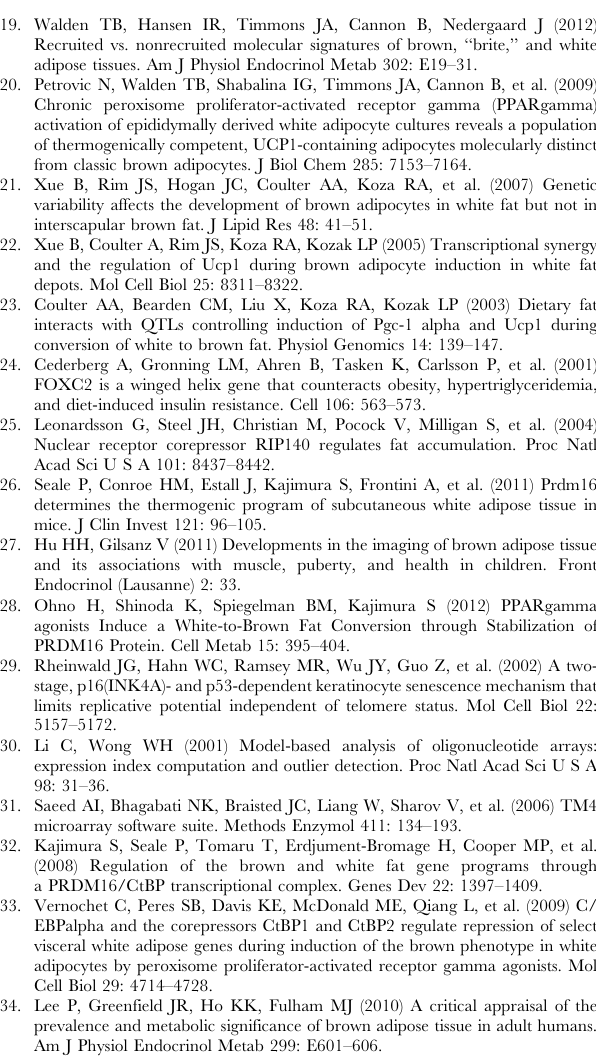
Figure S1 Expression profile after normalizing the each gene mRNA level with that of primary skin fibroblasts. Table S1 Primer sequences used in quantitative real- time PCR.